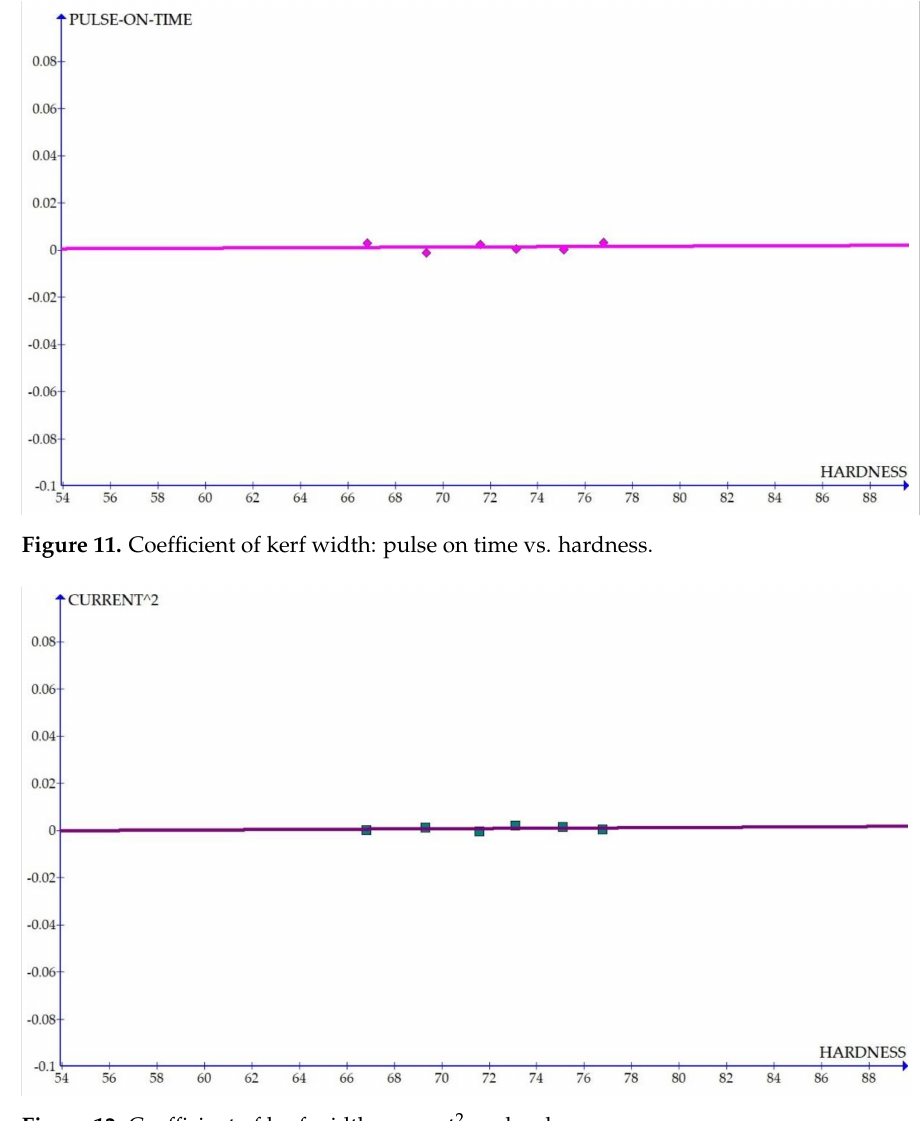
Figure 12. Coefficient of kerf width: current 2 vs. hardness.